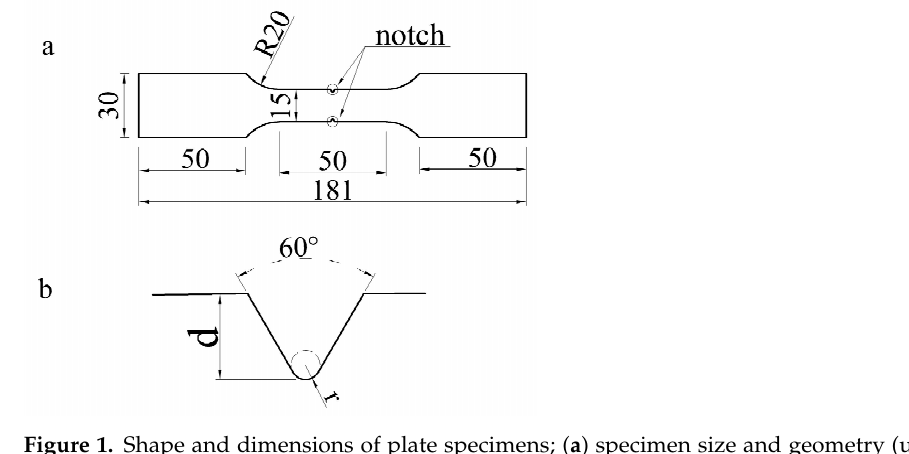
Figure 1. Shape and dimensions of plate specimens; ( a ) specimen size and geometry (unit: mm), ( b ) definition of notch size and geometry. Table 1. Summary of notch depth and root radius of specimens.